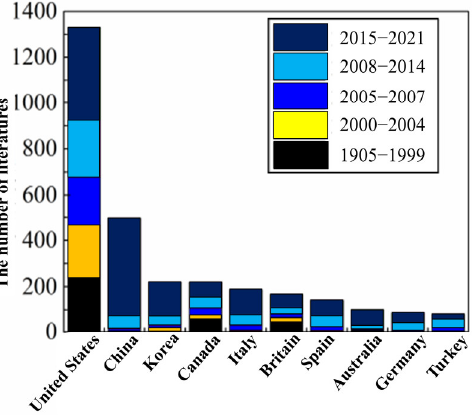
Figure 1. Literature Statistics of Prefabricated Concrete Structures in Various Countries.